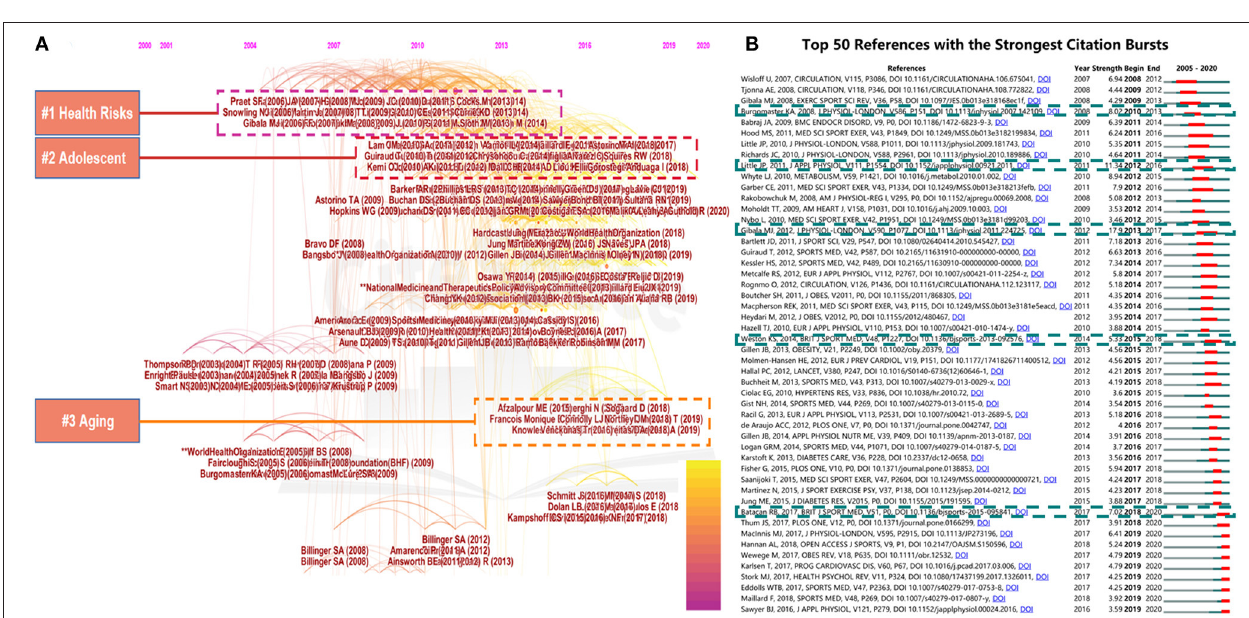
FIGURE 5 | The map of cooperation network of the authors in the HIIT-HP field (A) ; the map of the connections of the co-cited authors in the HIIT-HP field (B) .